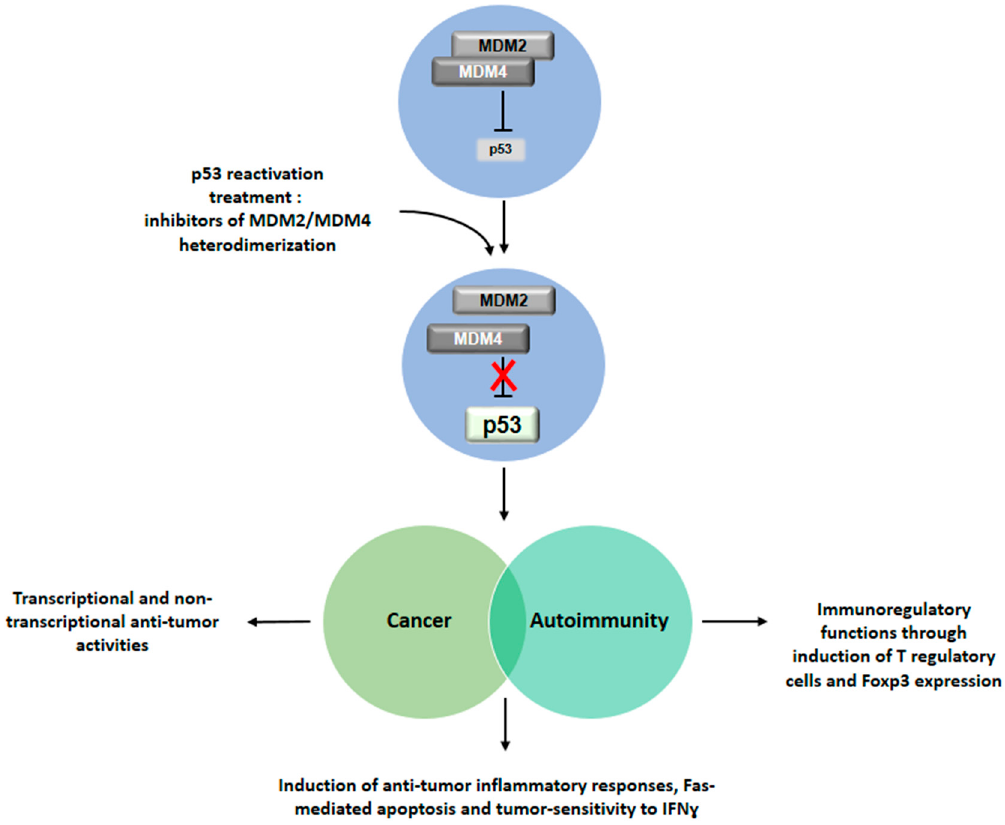
Figure 2. Implications of p53 reactivation for the treatment of cancer, autoimmunity and their associated conditions. Drug-induced inhibition of the MDM2/MDM4 heterodimer leads to reactivation of p53 function. Restored p53 activity would exhibit an anti-tumor role in cancer, an immunomodulatory activity in the context of autoimmune diseases and increased inflammatory immune response against tumor. This double effect could be exerted in patients affected by associated conditions of cancer and autoimmunity.